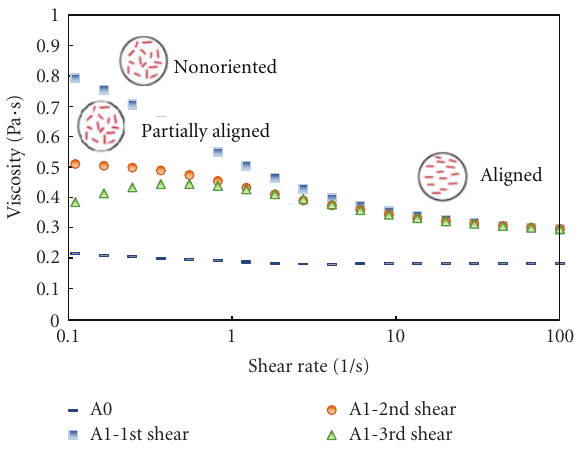
Figure 6: Successive shear viscosity sweeps at 23 ◦ C for 3% wt C30B nanoclay dispersed in petroleum-based resin R937 using the A1 mixing method.